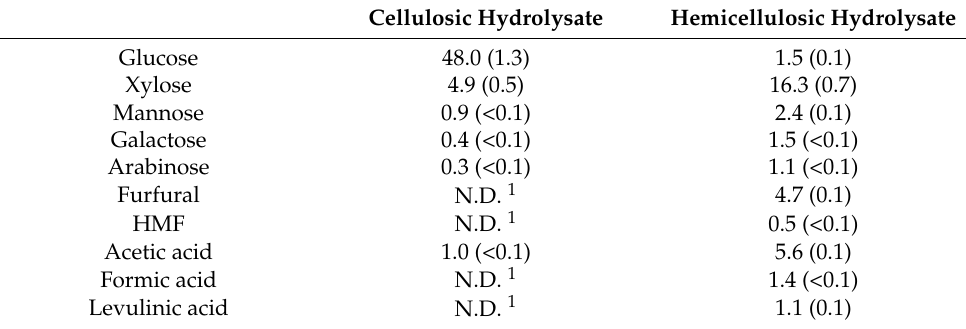
Table 2. Concentrations of sugars, furan aldehydes, and aliphatic acids in hydrolysates (g/L, mean values of triplicates). Standard deviations are shown in parentheses.